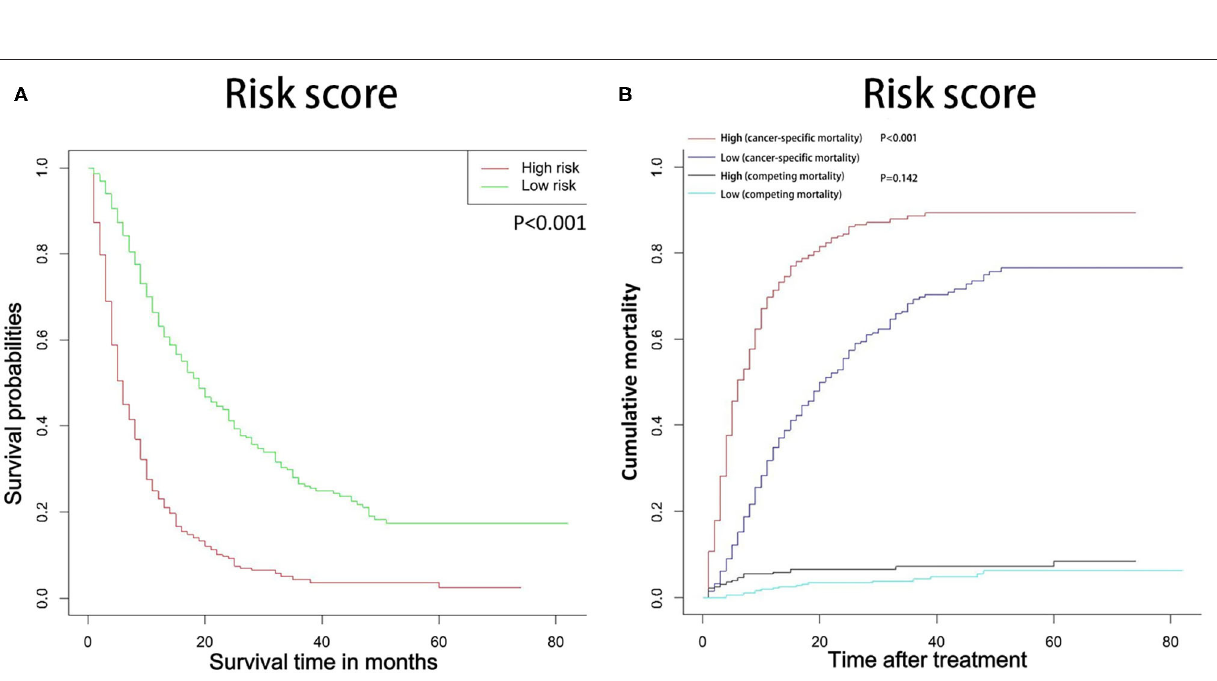
Frontiers in Surgery |